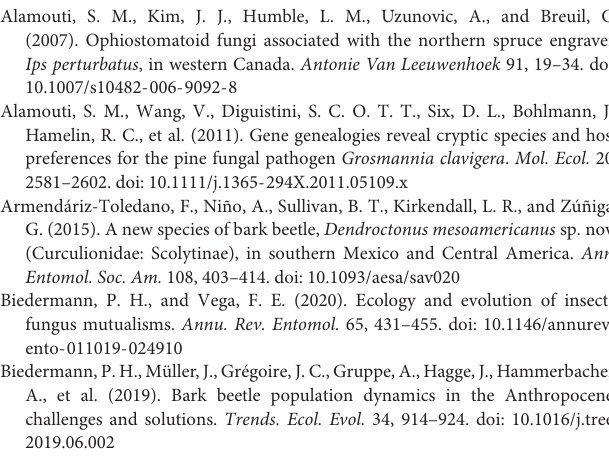
Supplementary Figure 1 | Phylogram of Ophiostoma piceae complex (including taxons 1 and 2) based on Tub2 sequence data. Bold branches indicate posterior probability values ≥ 0.9. The MP/ML bootstrap support values ≥ 70% are recorded at the nodes. H, ex-holotype; P, ex-paratype; T, ex-type isolates.